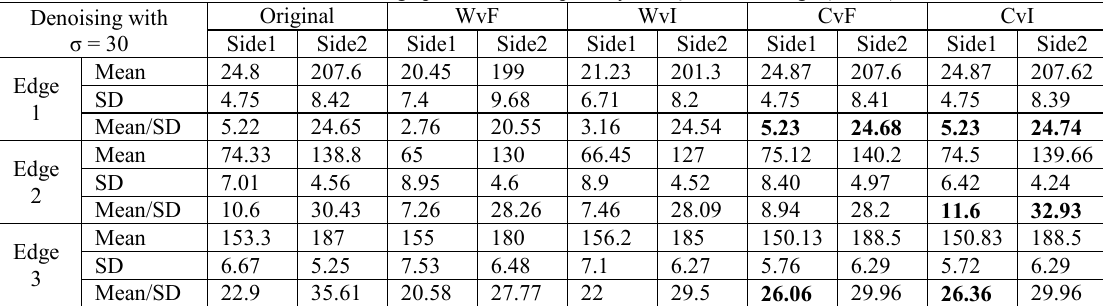
Table 4: Edge preservation capability for Quickbird image (σ = 30) Denoising with